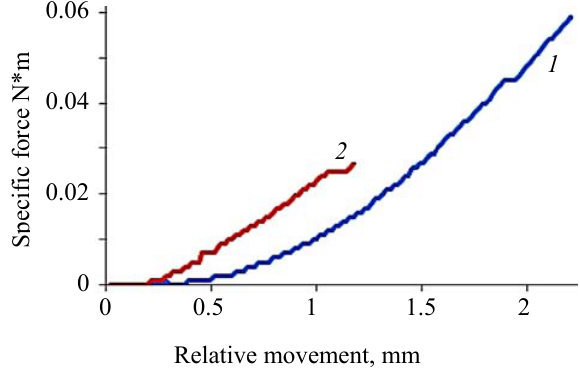
Fig. 3. Loading curves for the cutting of fresh carrots samples ( 1 ) Nantes carrots, ( 2 ) Forto carrots.